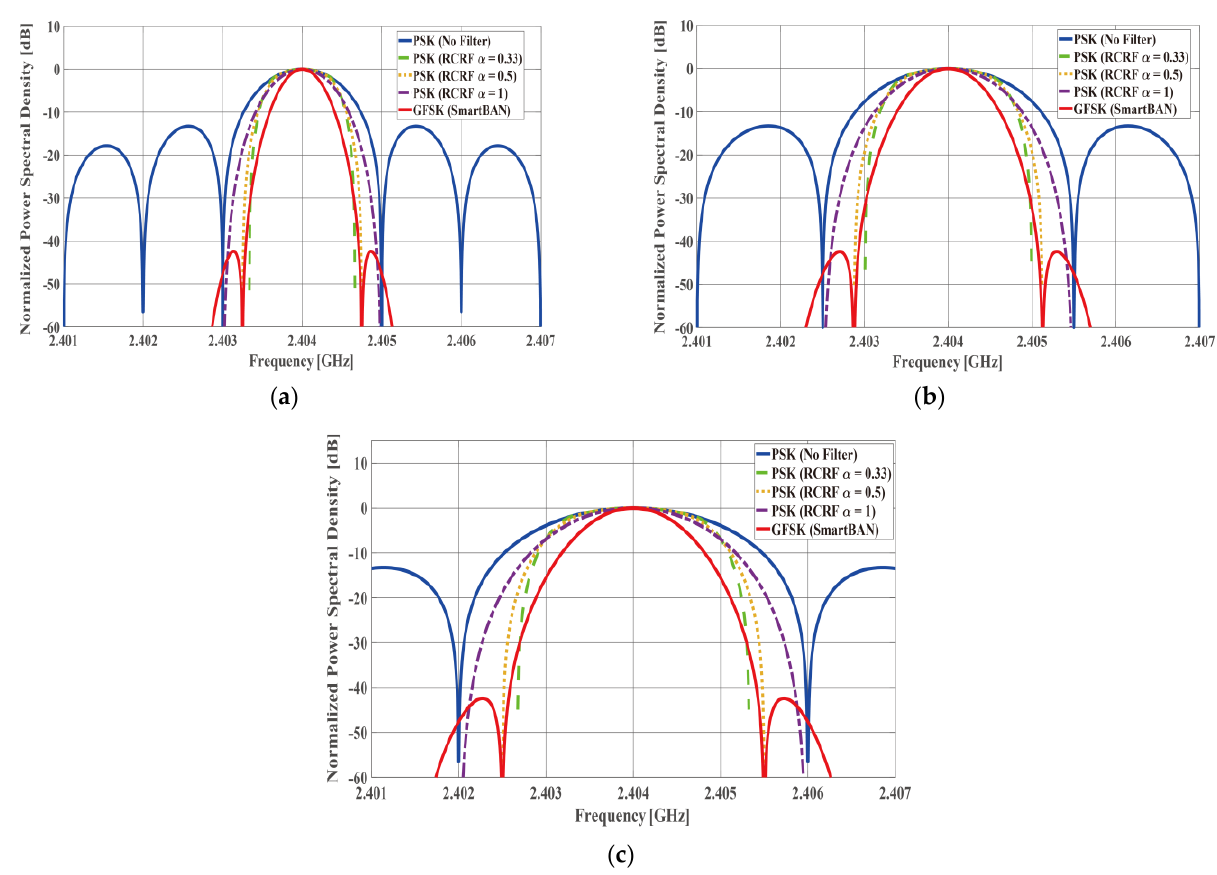
Figure 5. Normalized power spectral density (PSD) of Gaussian frequency shift keying (GFSK) and phase shift keying (PSK) in several constant 𝑅 𝑠 cases. ( a ) 𝑅 𝑠 = 1.0 Msps. ( b ) 𝑅 𝑠 = 1.5 Msps. ( c ) 𝑅 𝑠 = 2.0 Msps.